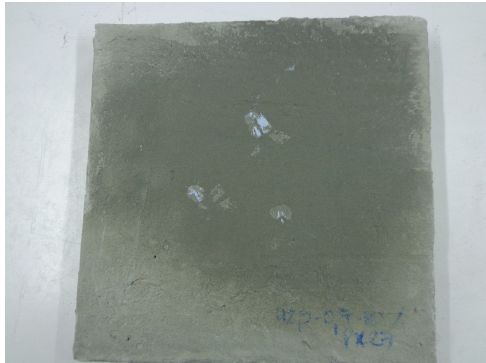
Figure 16. Heated PX27 hardened test